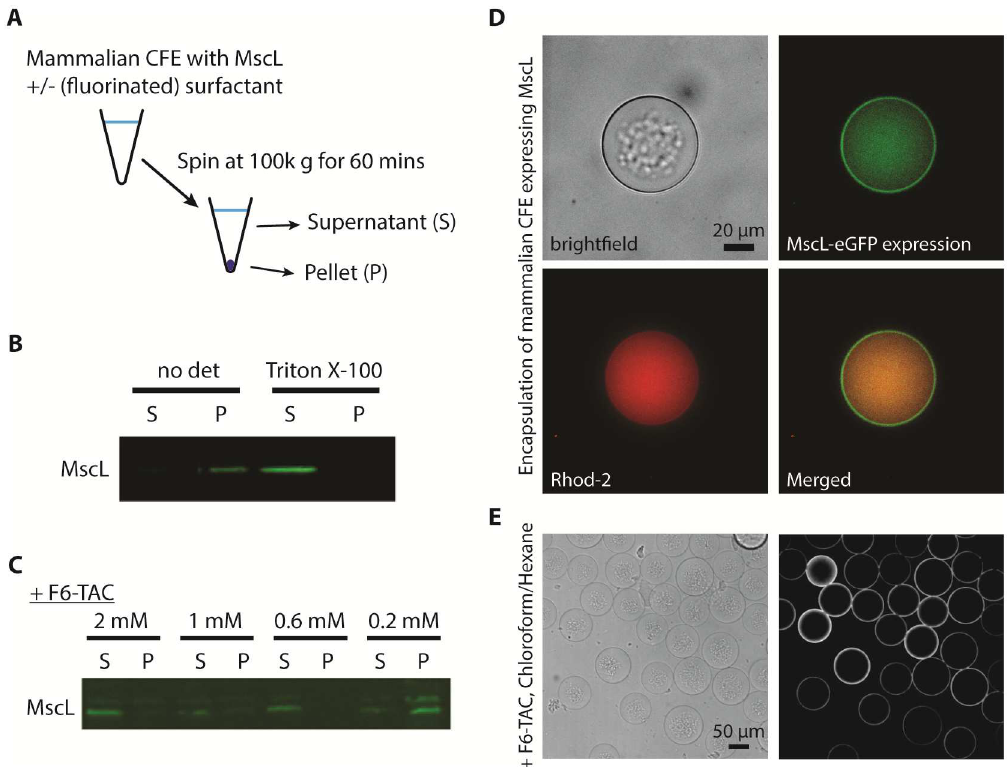
Fig 3. CFE of MscL is solubilized in fluorinated surfactants. (A) Schematic illustration of the solubilityassay for CFE of MscL. (B) Solubilityof CFE of MscL after 5 hr in the presence or absenceof 0.2% of Triton X-100. (C) Solubilityof CFE of MscL after 5 hr at different concentrations of fluorinatedsurfactant F6-TAC. (D) Formation of vesiclesencapsulating mammalianCFE expressingMscL in the presenceof 2% PVA and 0.6 mM F8-TAC. The vesicleswere formed from 36/64 chloroform/hexaneas the middlephase, and imagedin brightfield(top left) and in green fluorescence (top right). 5 μ M of calcium indicatorRhod-5Nand 1 mM of calcium was also encapsulated inside the vesicle (bottom left). Mergedimage of green and red fluorescence is shown in the bottom right. (E) Formation of HeLa lysate encapsulated vesicles formed from 40/60 chloroform/hexane in the presenceof 2% PVA and 2 mM F6-TAC, imagedin brightfield(left) and in fluorescence